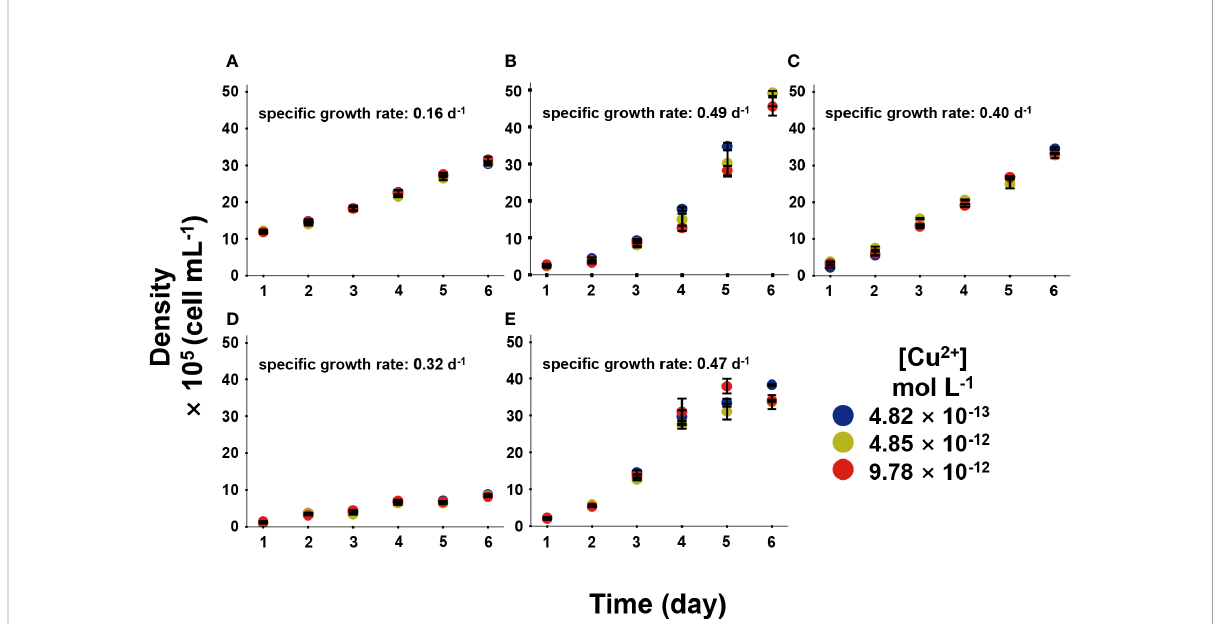
FIGURE 2 The growth of fi ve phytoplankton, in which (A) , Isochrysis zhanjiangensi , (B) , Phaeocystis sp., (C) , Isochrysis galbana , (D) , Chaetoceros sp. and (E) , Phaeodactylum tricornutum sp. sp., during 6 day exposure of 4.82 × 10 -13 , 4.85 × 10 -12 , and 9.78 × 10 -12 mol L -1 [Cu 2+